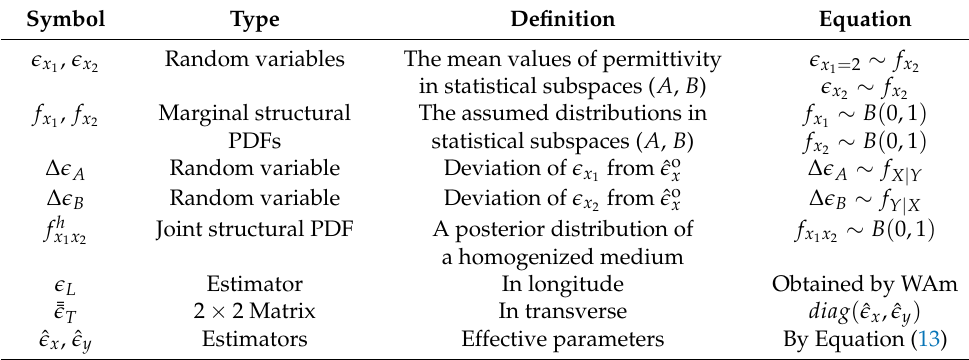
Table 1. Definitions of the variables and functions. Symbol Type